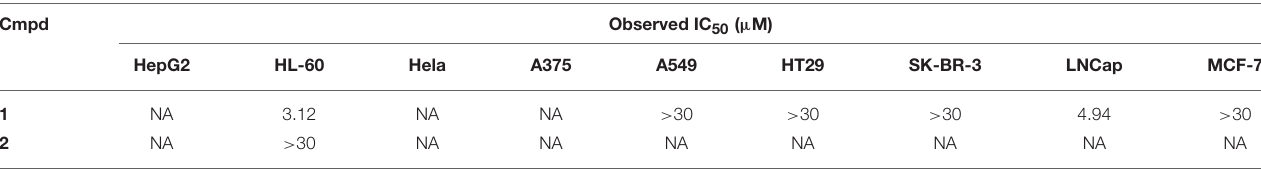
TABLE 2 | Biological evaluation of misszrtine A ( 1 ) and compound 2 a .